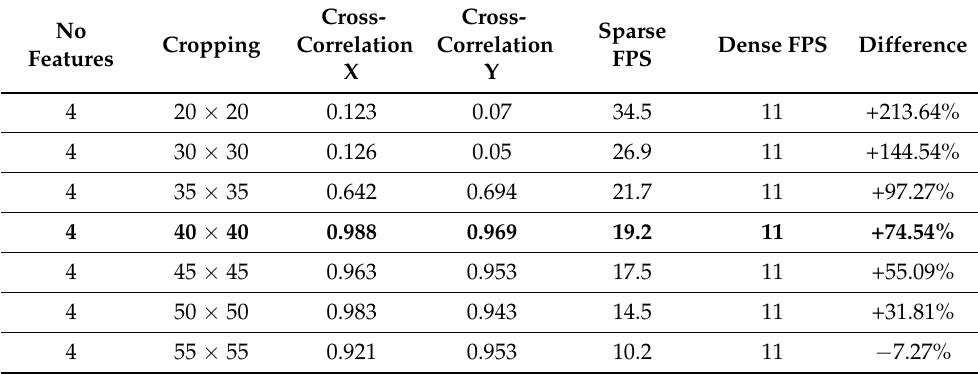
Table 4. The effect of cropping window on accuracy and processing time of the